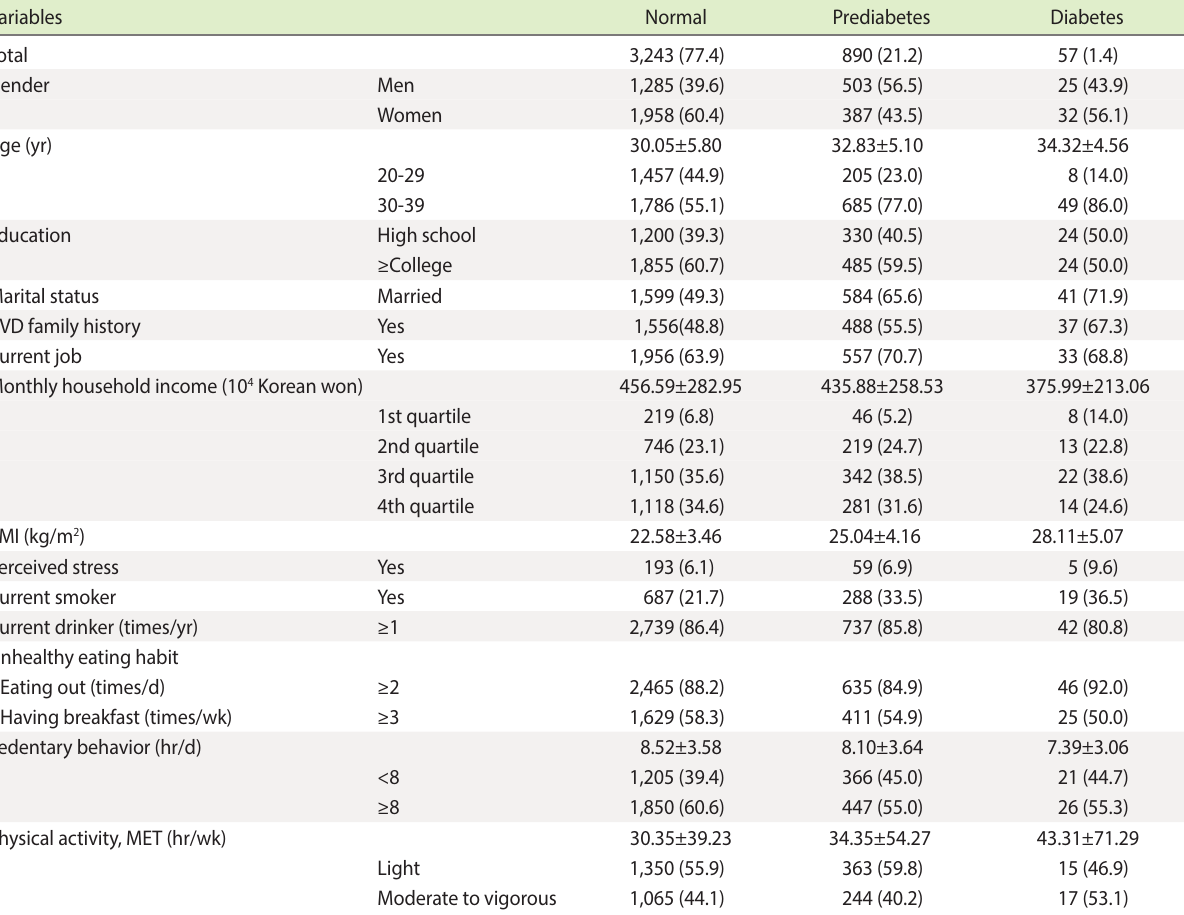
Table 1. Comparison of subject characteristics of three groups with fasting blood sugar and hemoglobin levels (n=4,190)